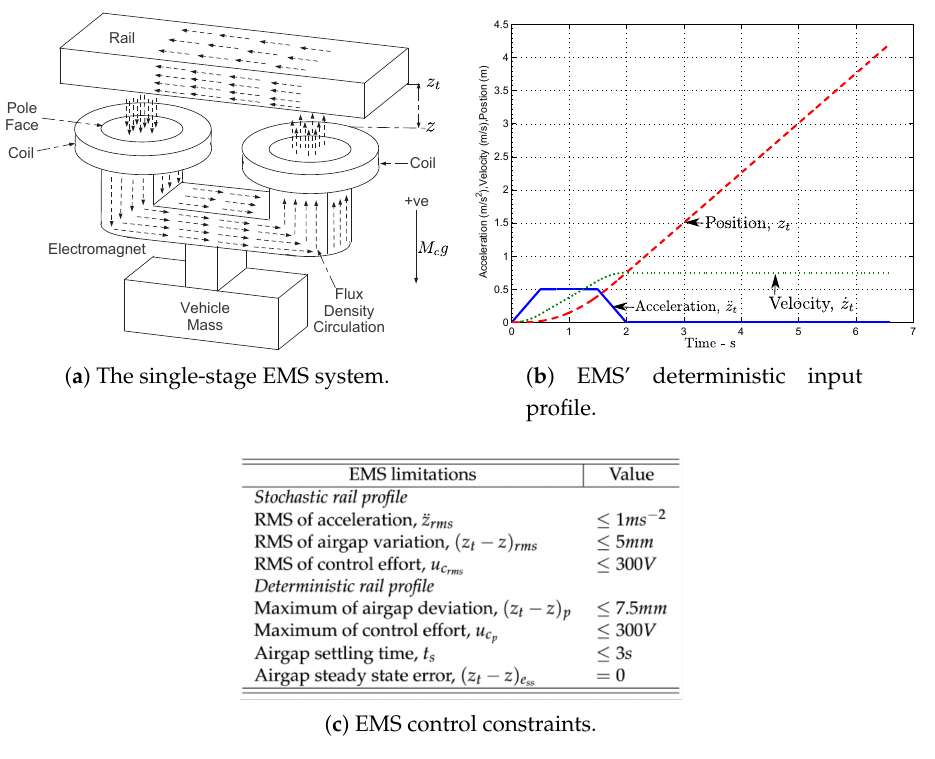
Figure A1. EMS systems and its